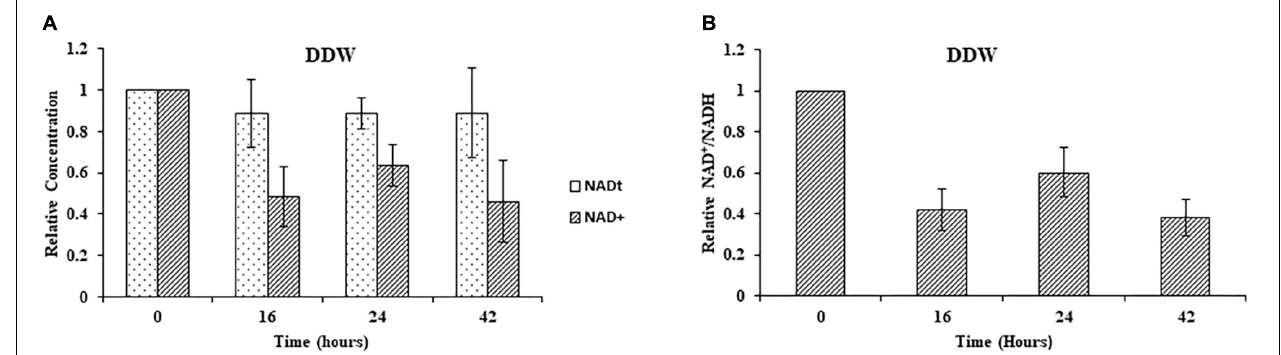
FIGURE 7 | Changes in total NAD levels and NAD + oxidation status during germination of conidia under nutrient-free conditions. (A) Relative concentrations of total NAD (NADH + NAD + ) and NAD + in F. oxysporum conidia growing in DDW at different time intervals. (B) Redox ratio of F. oxysporum conidia growing in DDW for different time intervals. NAD was extracted and measured as described in Materials and Methods. Vertical bars represent relative values with respect to initial concentration at 0 h. Values are mean ± SD. Vertical lines represent standard error